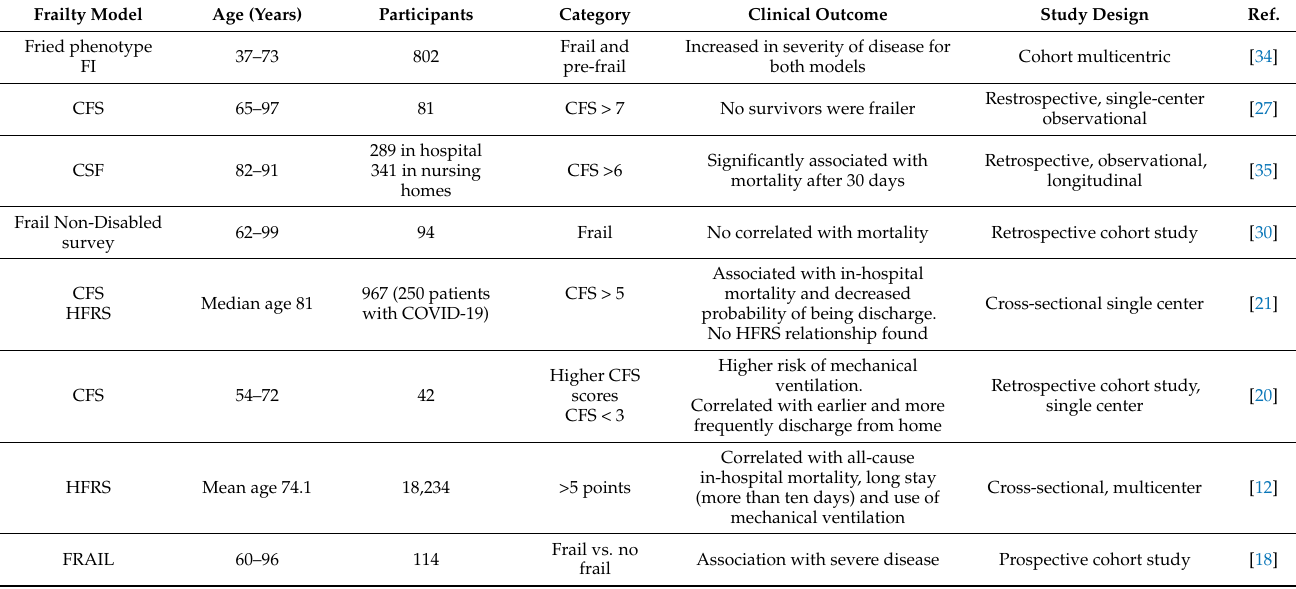
CFS (clinical frailty scale), FI (frailty index), HFRS (Hospital frailty risk